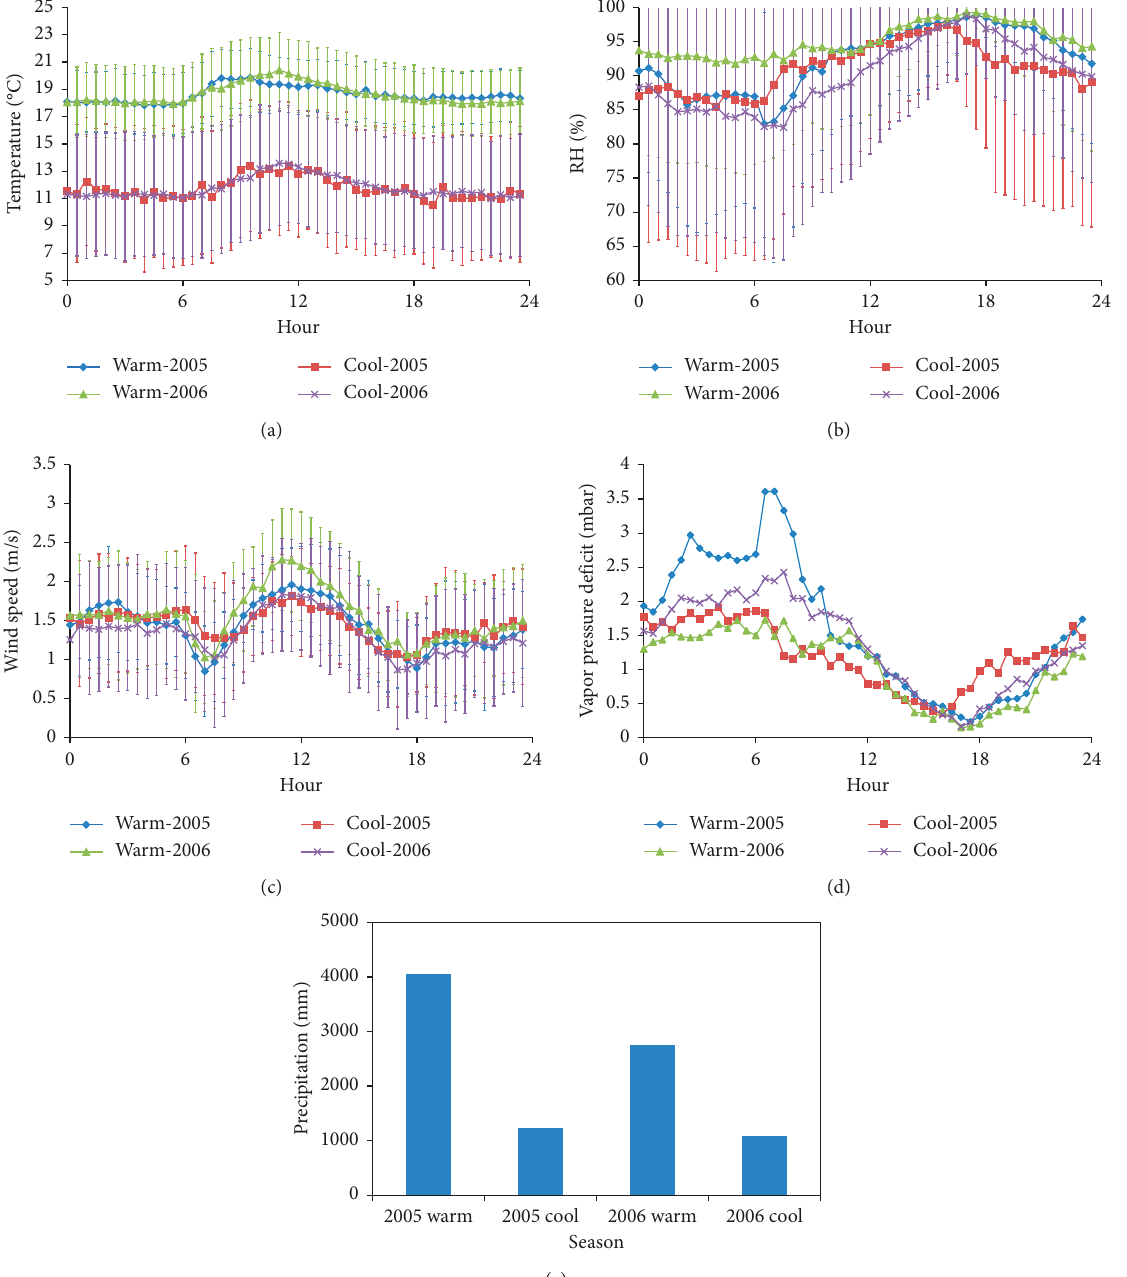
Figure 1: Averaged diurnal variations of (a) air temperature, (b) relative humidity, (c) wind speed, and (d) vapor pressure deficit for the warm (May to Oct.) and cool (Nov. to April) seasons of 2005–2006. The vertical bars indicate the standard deviations. (e) Precipitation for each